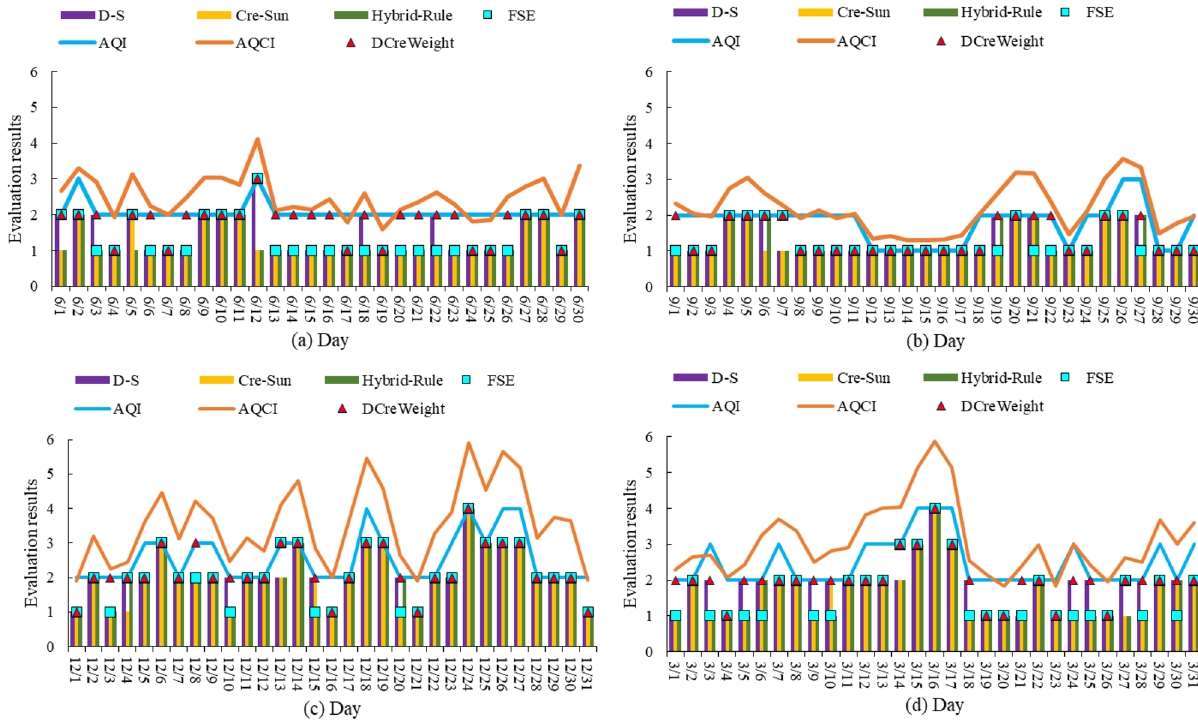
Figure 3. Daily air quality in Xi’an in four seasons. ( a ) Daily air quality in Summer; ( b ) daily air quality in Autumn ( c ) daily air quality in Winter; ( d ) daily air quality in Spring.